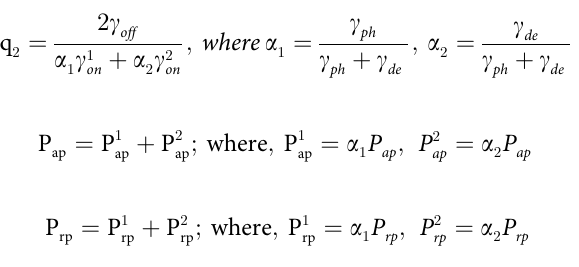
; γ 2 along node and internode for ‘8-state’ model. on on